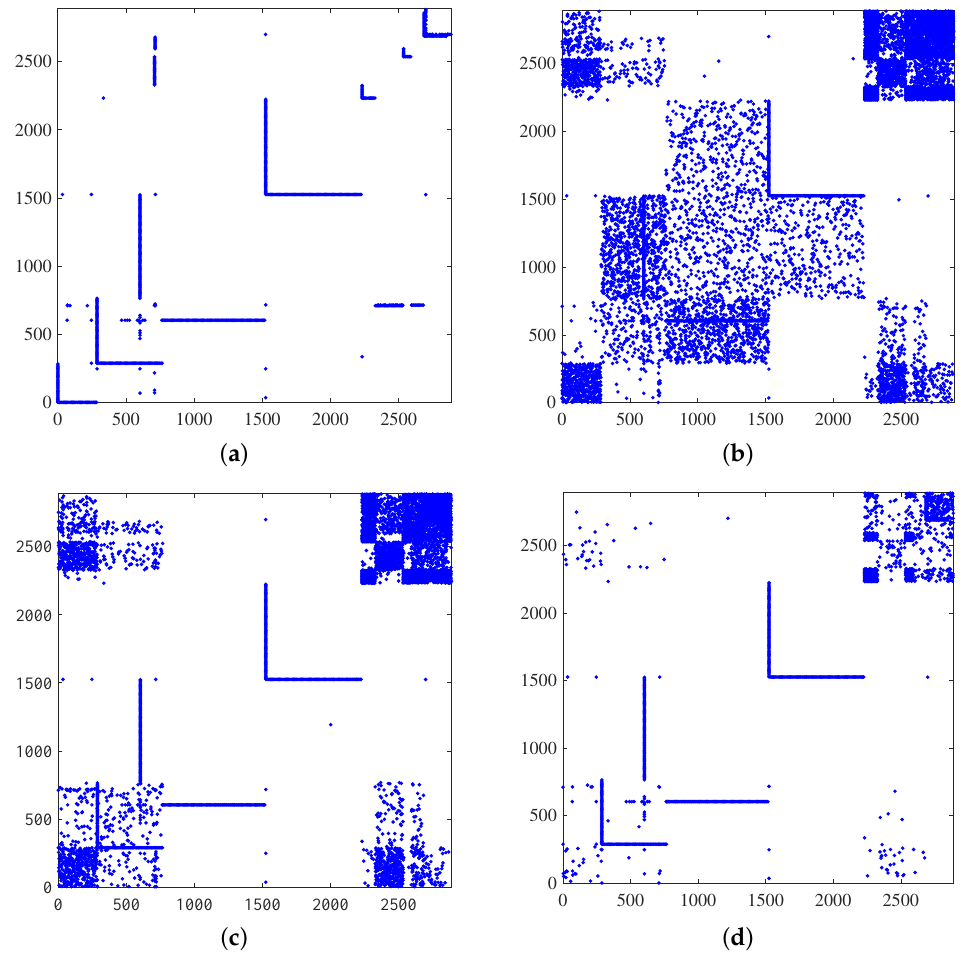
Figure 1. Recovery of Facebook friendship graph with N = 2882 nodes. Adjacency matrix of ( a ) ground-truth network; and estimates for ( b ) T = 10 4 ; ( c ) T = 10 5 ; and ( d ) T = 10 6 . It is apparent how recovery performance markedly improves as the sample size increases; see also the accompanying table with the corresponding F-measure